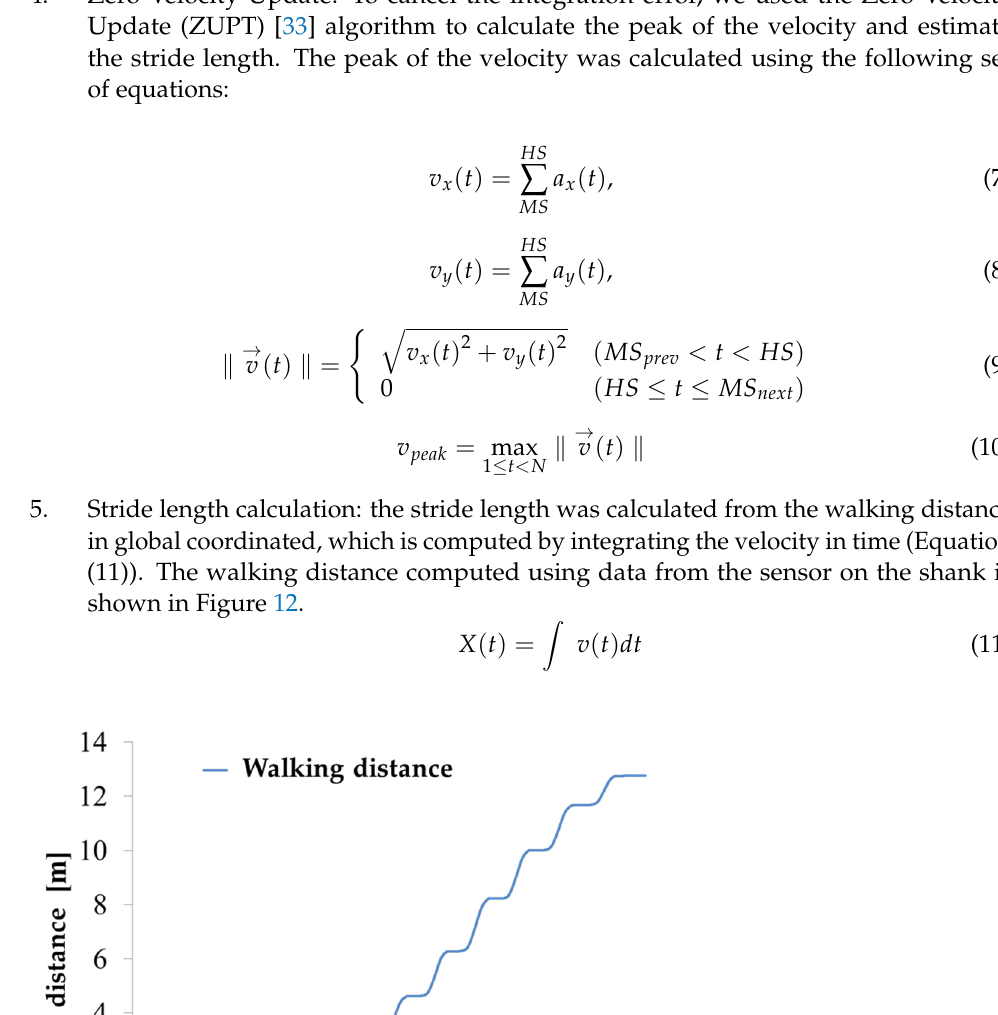
Figure 11. Walking distance of IMU on the ankle.